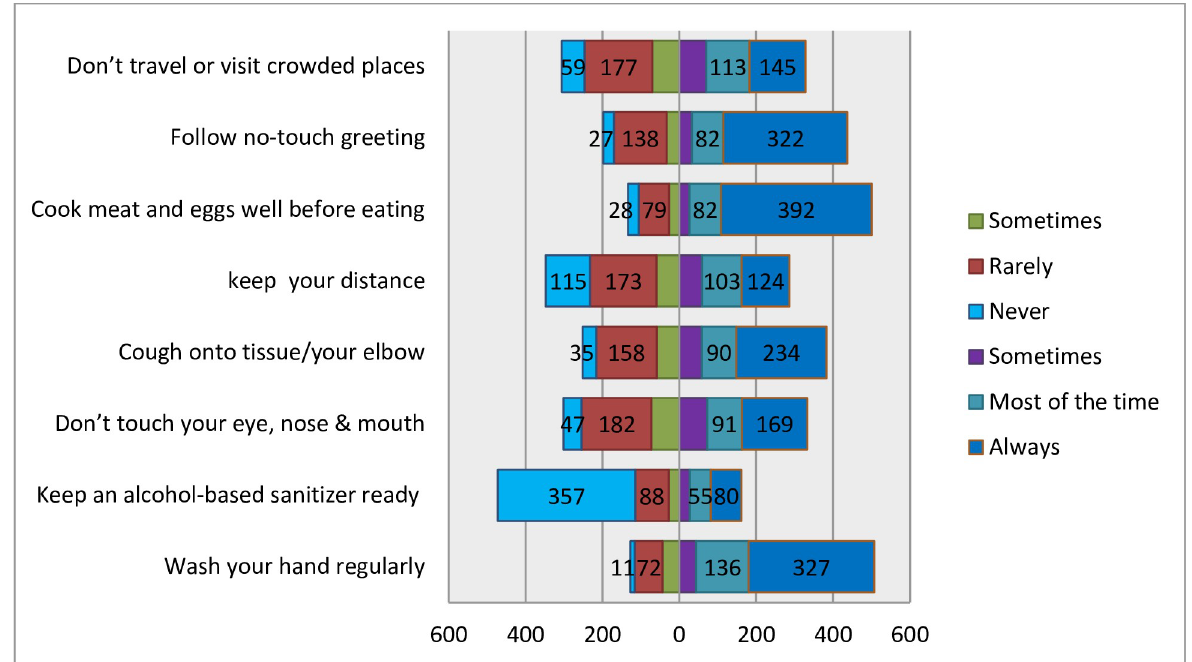
Fig 1. Distribution of COVID-19 preventive behaviors, Qellam Wallaga Zone, Oromia, Ethiopia, 2020.